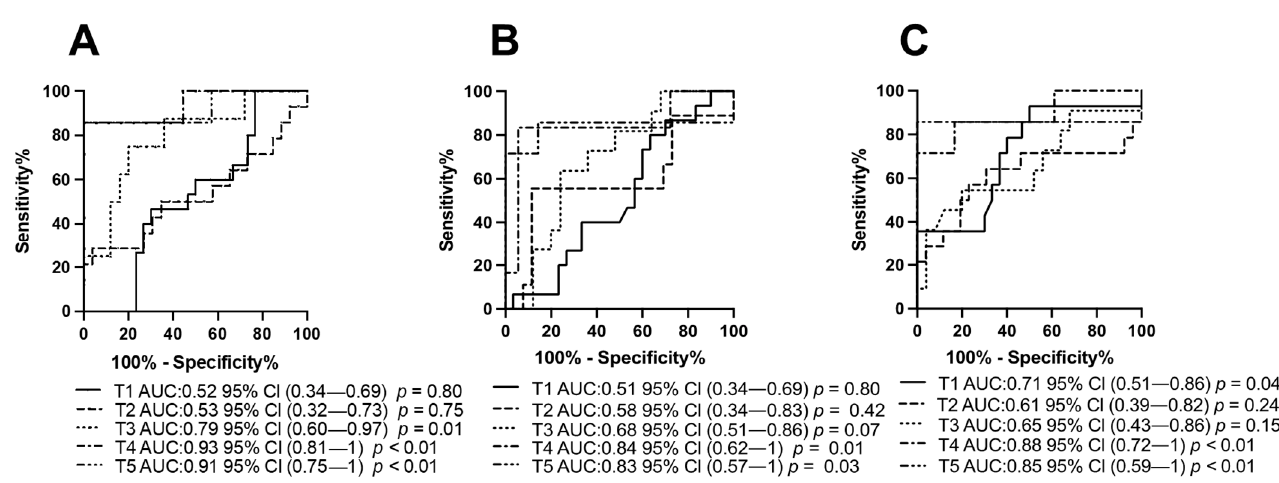
Figure 3. Predictive potential of miRNA expression in serum exosomes at different time points in Stable and Progressed patients. ROC curves showing sensitivity and specificity for miR-21 ( A ); -222 ( B ) and -124-3p ( C ) expression. AUC is area under the curve.